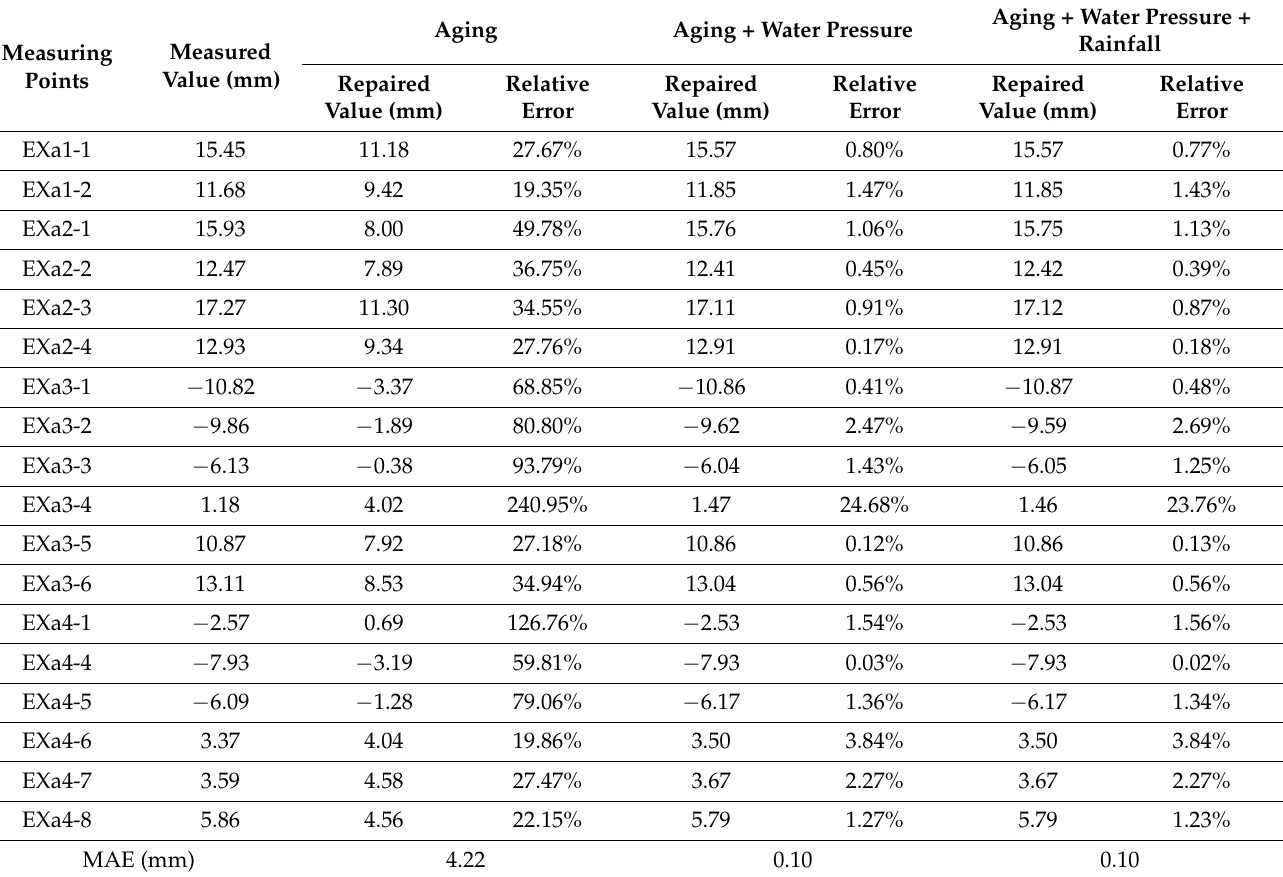
Table 2. Spatial repair results with selection of different covariates of the two-dimensional